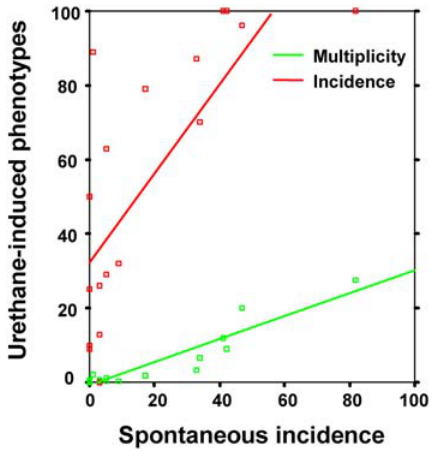
Figure 1. Spontaneous lung tumor incidence correlates with both urethane-induced lung tumor multiplicity (green) and incidence (red) in mouse inbred strains. Incidence is given as mean percentages, whereas multiplicity is mean number of tumors/